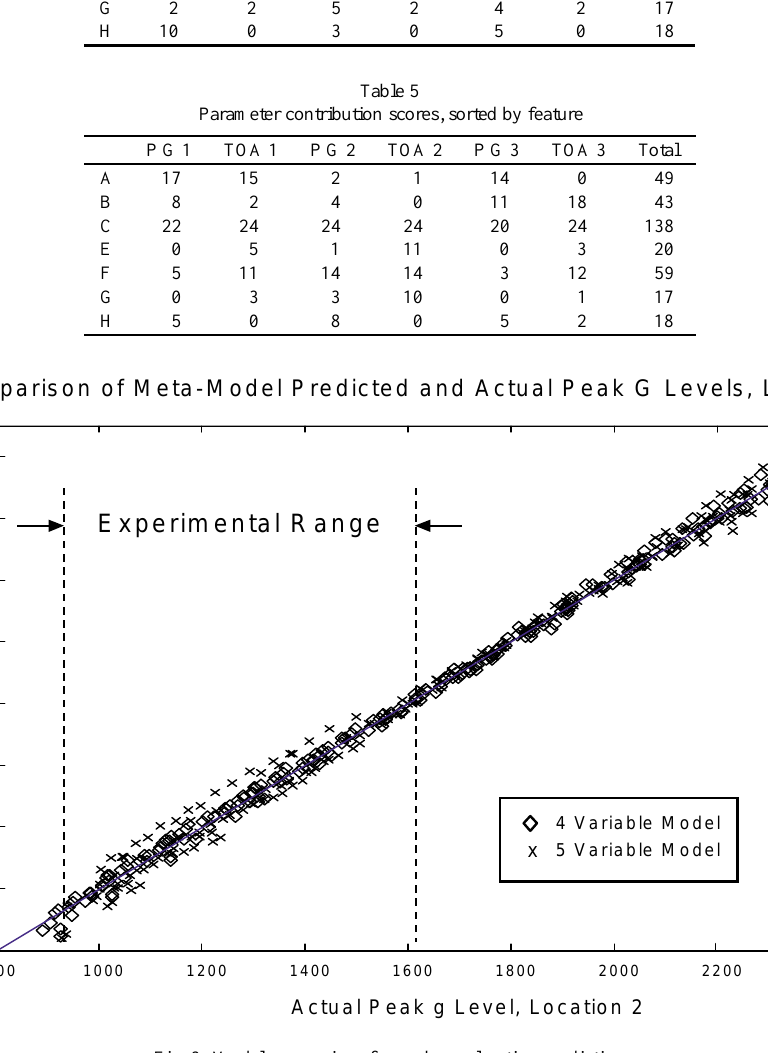
Fig. 8. Model comparison for peak acceleration